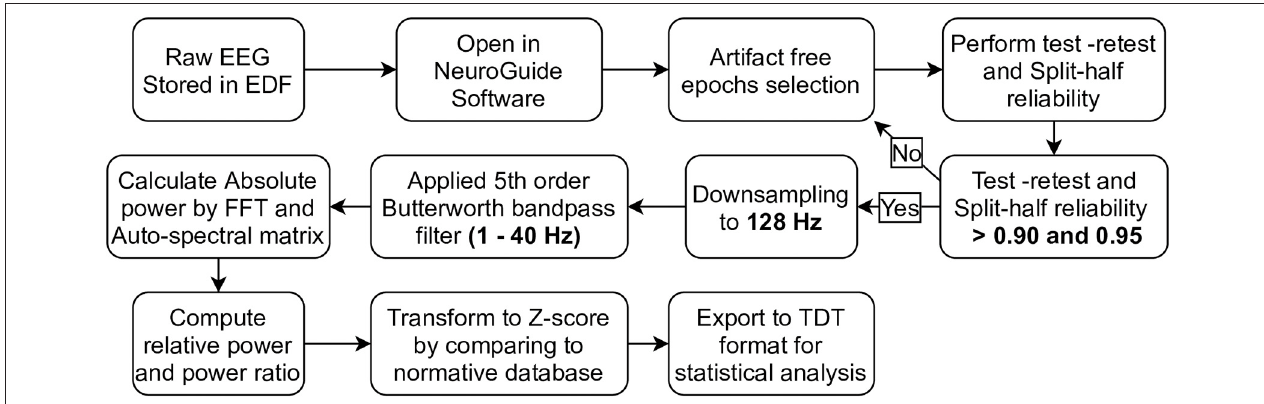
FIGURE 1 | The pipeline of EEG preprocessing, validation, and transformation by using NeuroGuide software were demonstrated in step